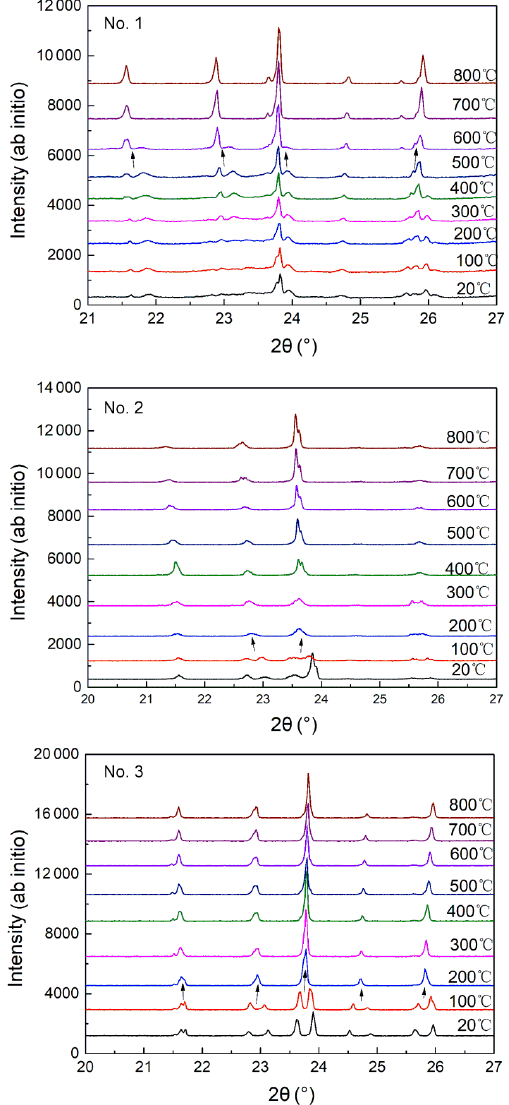
Figure 2. XRD patterns of the three samples at elevated tempera- tures with arrows indicating displacive phase transition.